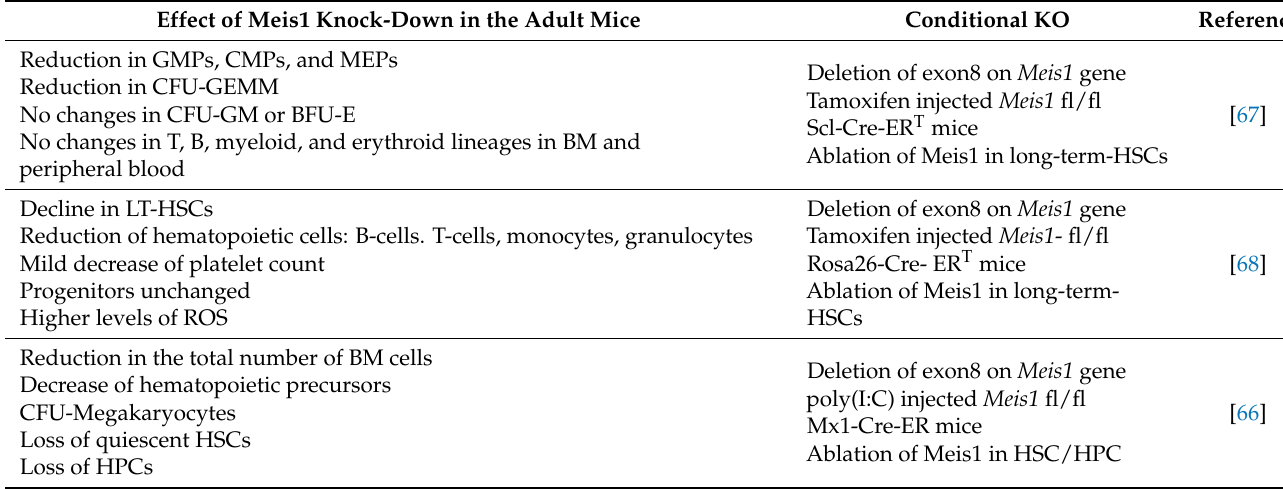
Table 1. Summary of the effects of MEIS1 deletion in the hematopoietic cells of adult mice. Effect of Meis1 Knock-Down in the Adult